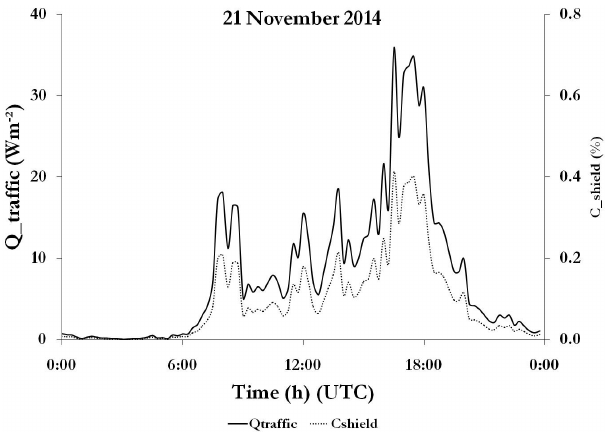
Figure 3. Hourly variations of thermal traffic contributions, and variations of the shield effect coefficient (rue Charles III, Nancy, France) for the first experiment.